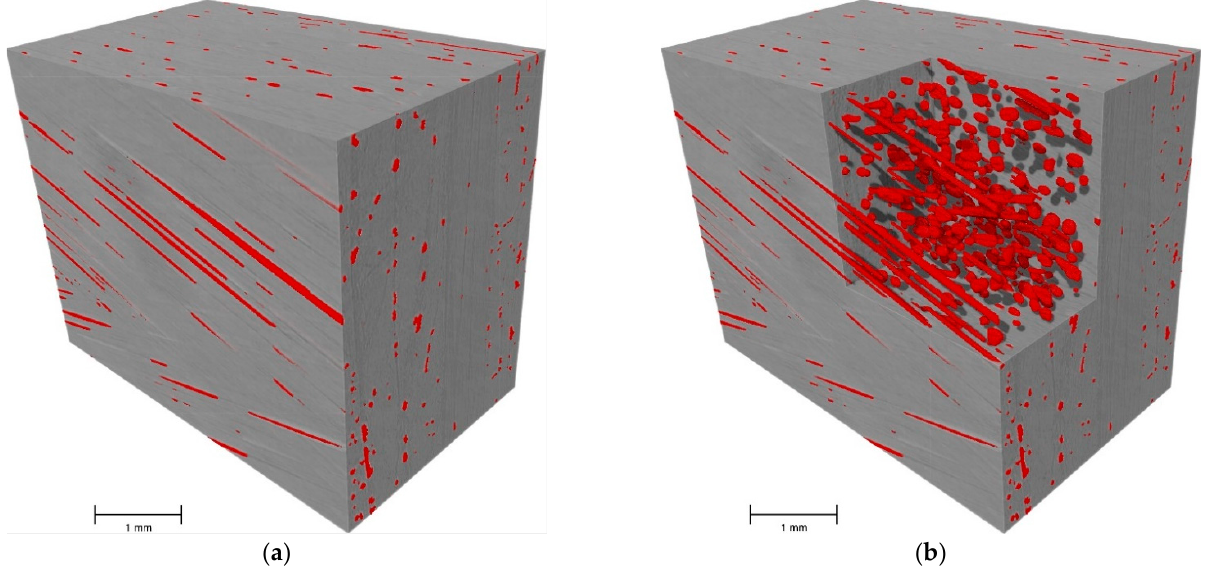
Figure 9. Scanned sample “µCT 2” showing the composite in grey and the voids in red; ( a ) the scanned sample, ( b ) a section cut showing the voids in the sample.